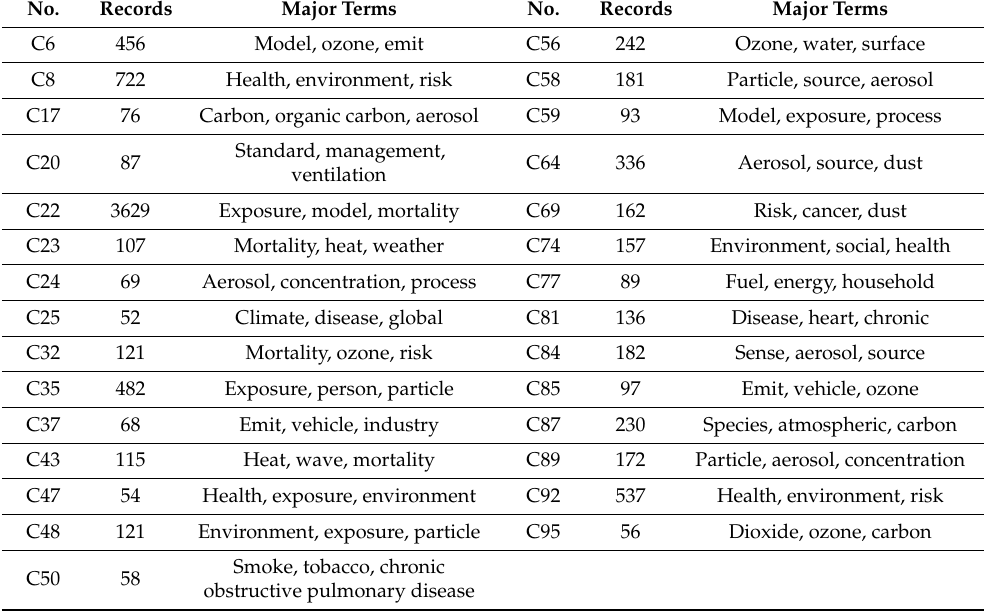
Table 3. The selected clusters (records > 50) by OmniViz analysis.